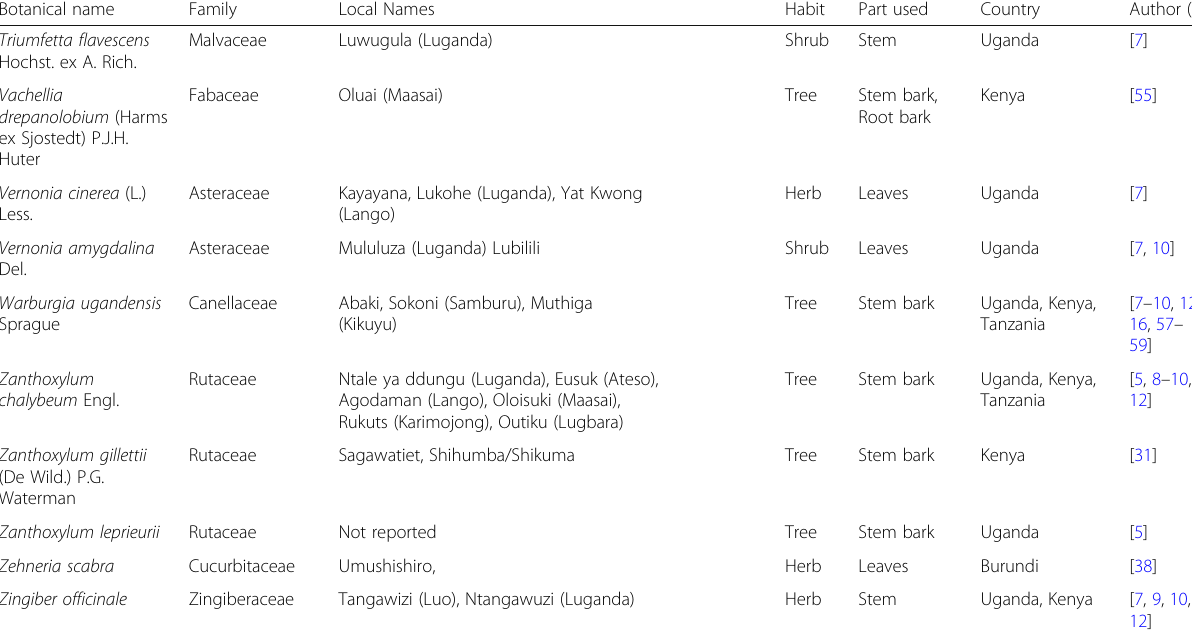
Table 1 Medicinal plants used in treatment of symptoms of TB in East Africa